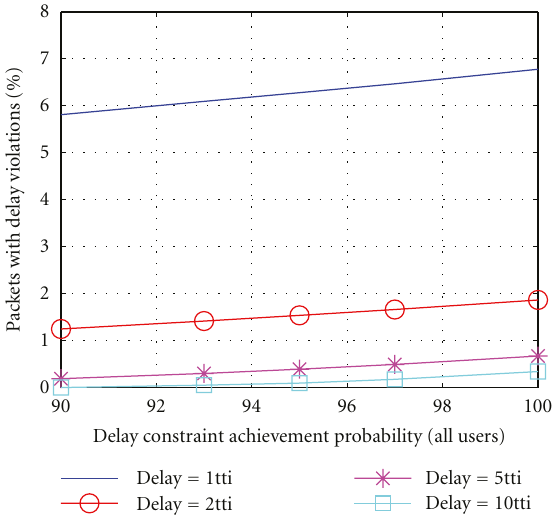
Figure 8: Average output sum rate versus average sum input arrival rate. Users = 14, Subcarriers = 40, Cell Radius = 700 m, and tti =